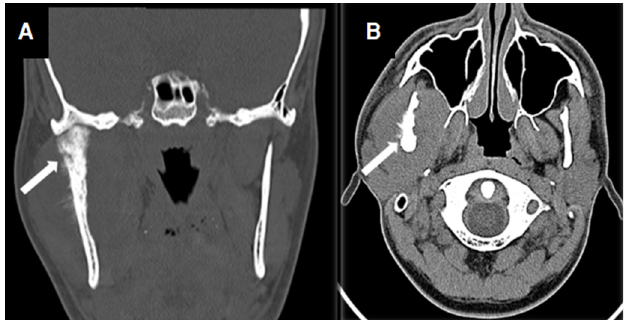
Fig. 3. (A and B) Axial and coronal sections of the pre-chemotherapy CT scan showing periosteal reaction with loss of retromaxillary fat (indicated with